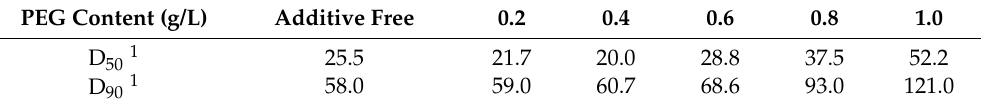
Figure 4. Grain size distribution curve of Mg(OH) 2. Table 2. Particle size distribution data of electrolytic products with different PEG addition.